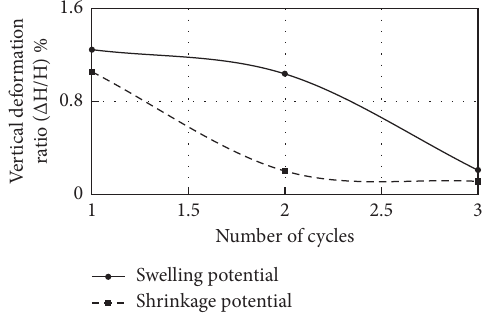
Figure 12: Swelling/Shrinkage potential versus the number of cycles for